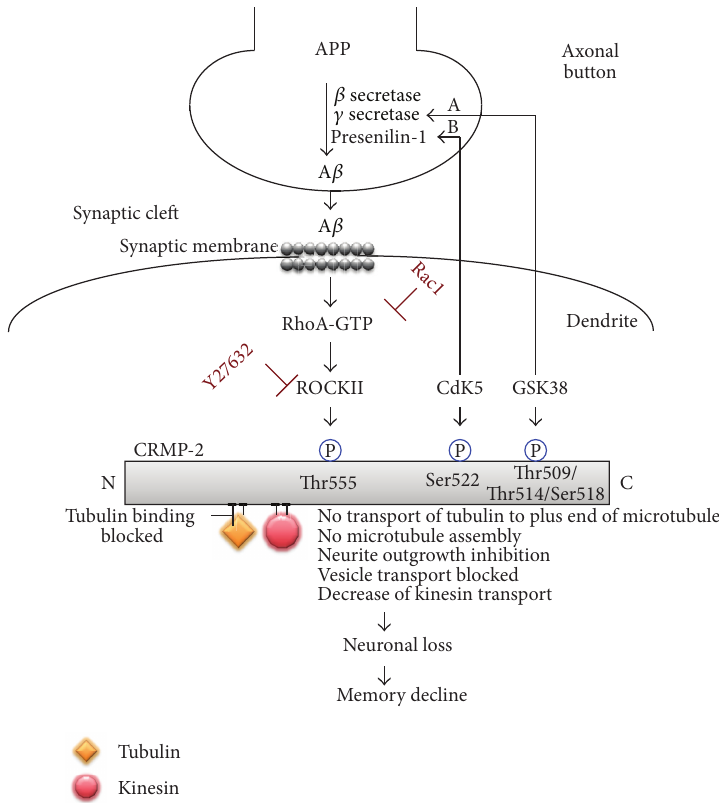
Figure 3: Model of A 𝛽 -mediated neurite outgrowth inhibition. A 𝛽 (oligomeric) activates the small GTPase, RhoA, which inhibits the proneurite outgrowth GTPase Rac1. RhoA-GTP activates Rho Kinase (ROCK II) to effect microfilament rearrangement and also potentiate microtubule disassembly. Microtubule disassembly occurs when ROCK II directly phosphorylates CRMP-2 at the Thr555 position preventing the association of CRMP-2 with tubulin heterodimers, thereby affecting neurite outgrowth inhibition. Neurite outgrowth is further impeded by CRMP-2 phosphorylation since this prevents the microtubule motor protein, kinesin, to associate with CRMP-2 and transport growth- related vesicular cargo, such as BDNF, antergradely to the distal end of the neurite. It is demonstrated that CRMP-2 is also phosphorylated by GSK-3 𝛽 and Cdk-5. (A) Studies have demonstrated that GSK-3 𝛽 activity can also regulate the processing of APP resulting in the production of A 𝛽 , which in turn can further increase GSK-3 𝛽 activity through PI3K inhibition, illustrating as a potential feedback loop. (B) Additionally, it has been suggested that Cdk5 may phosphorylate presenilin-1 at Thr354 destabilising its carboxy-terminal fragment, leading to increased APP